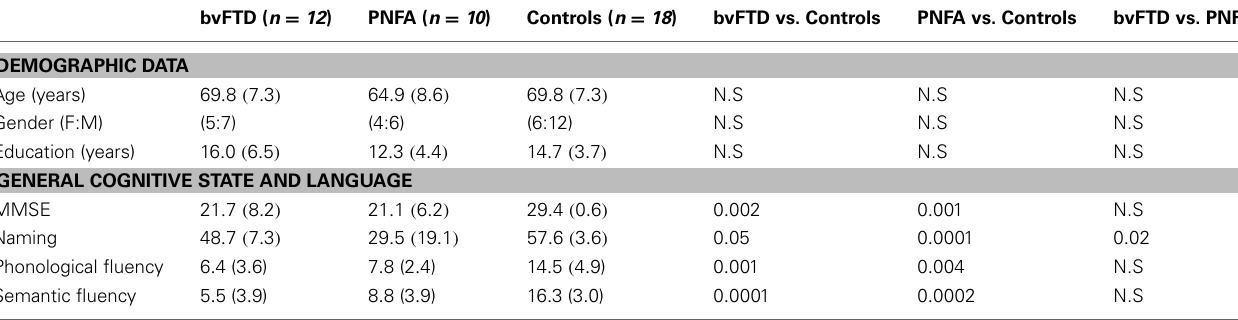
Table 1 | Demographic data and results of cognitive state and language